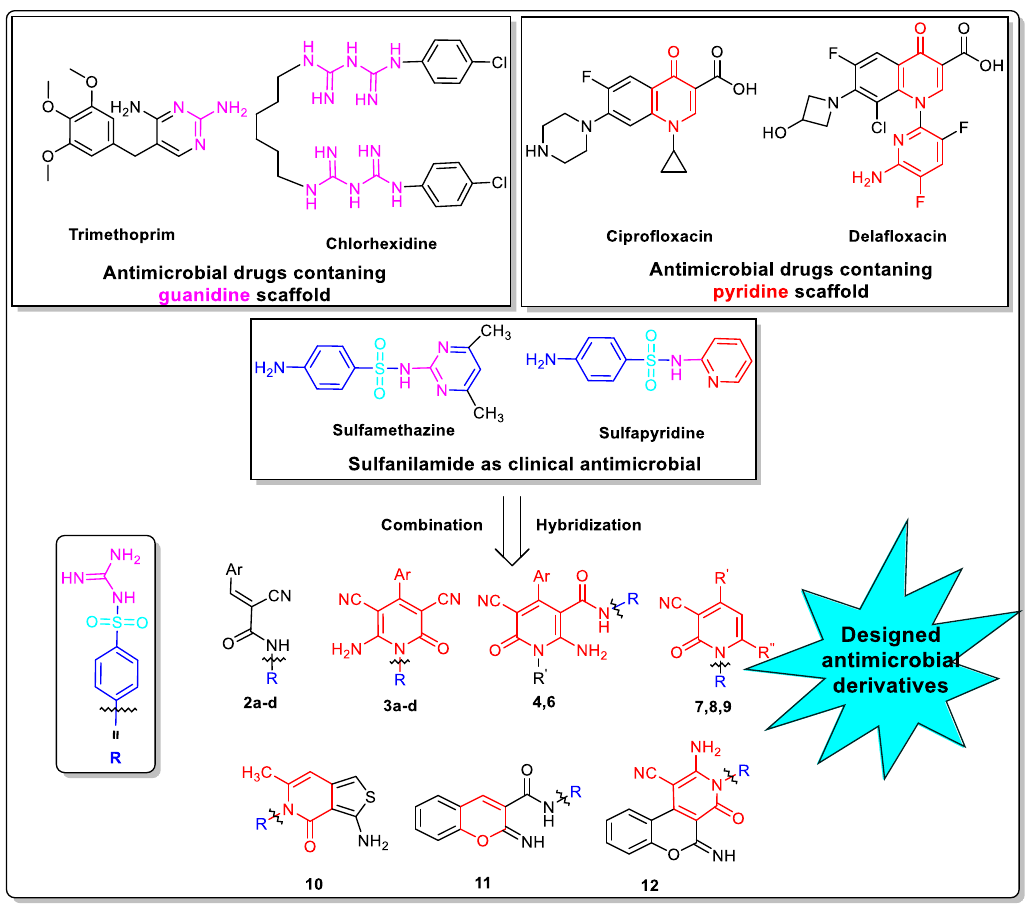
Figure 1. Rational study design, illustrating the structure of the newly designed sulfa guanidine derivatives with representative examples for antimicrobial drugs that contain guanidine, pyridine, and sulfonamide moieties.